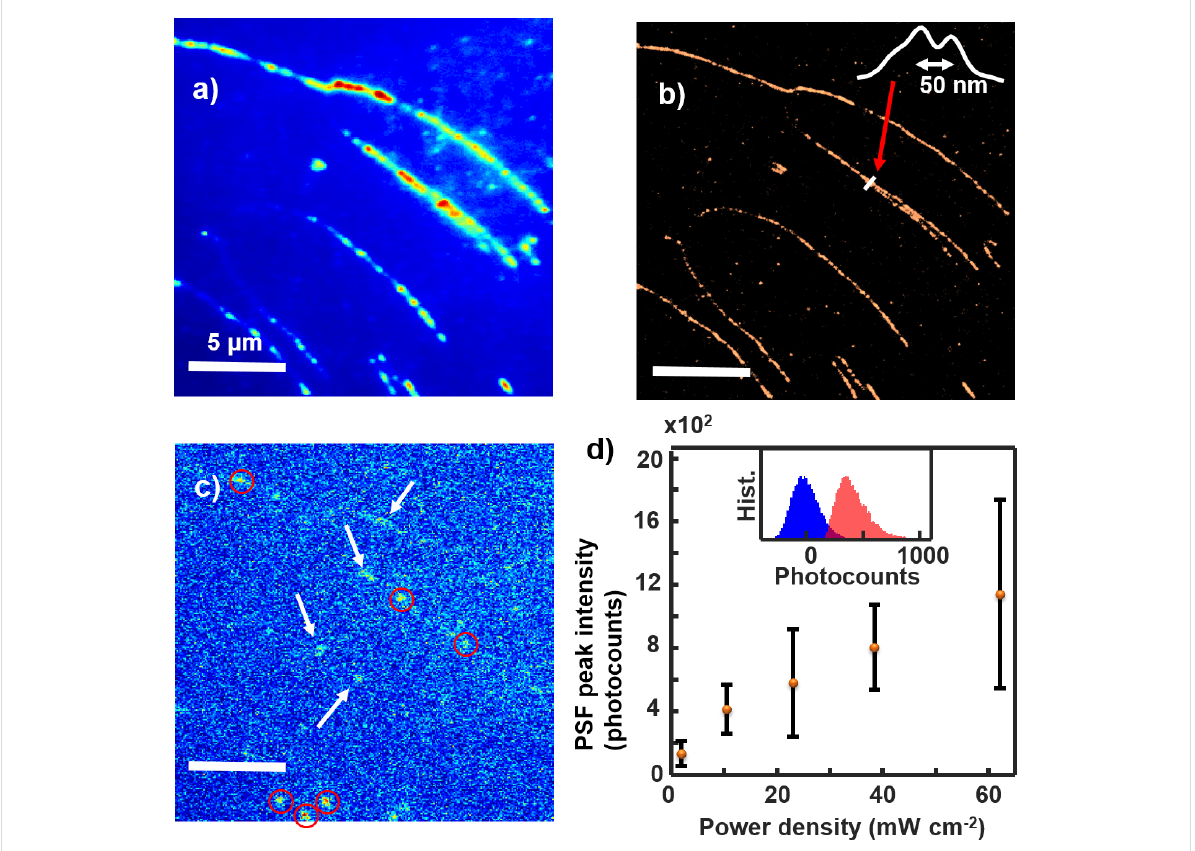
Figure 7: (a) Fluorescence images of regular and (b) super-resolved YOYO–DNA (inset shows a line profile across two nearby DNA molecules). Laser power density 23 W cm − 2 . (c) A single frame of the video of fluorescent images. The circles are events chosen and the arrows are events discarded in generating the image in (b). (d) PSF peak intensity as a function of laser power density (inset shows histograms of the background and PSF peak intensities, see Supporting Information File 1, Figure S4 for larger images). The error bars represent the standard deviation of the photo- counts of YOYO-1 molecules for three